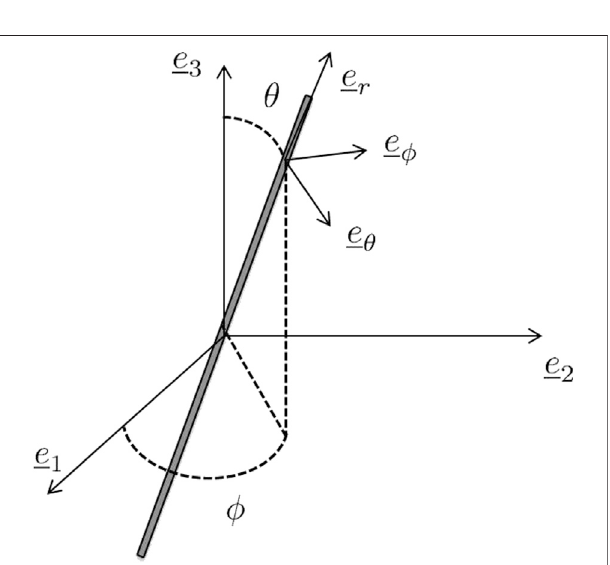
FIGURE2| De fi nitionofthelocalreferencesystem e r , e θ , e ϕ associated with a speci fi c fi ber phase; and associated Euler angles θ and ϕ .